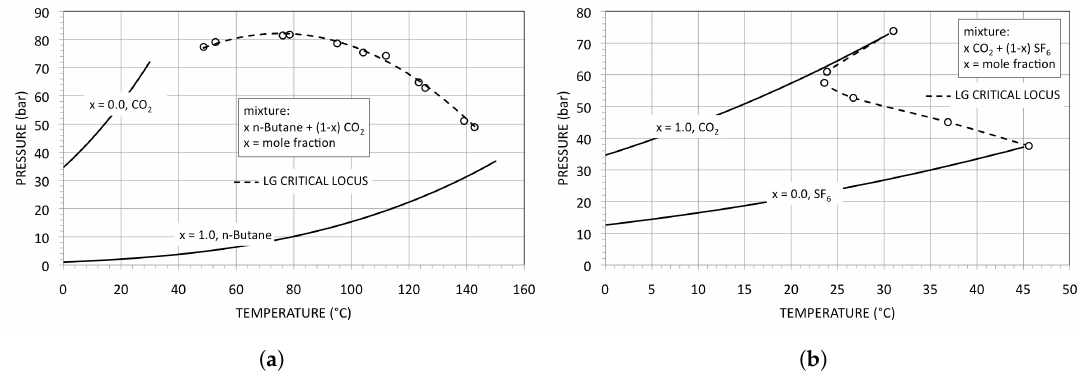
Figure 10. ( a ) Liquid–gas (LG) critical loci for binary mixtures of n -butane and carbon dioxide. Data are from [29]; ( b ) LG critical loci for binary mixtures of carbon dioxide and sulphur hexafluoride (SF 6 ). Data are from [28].